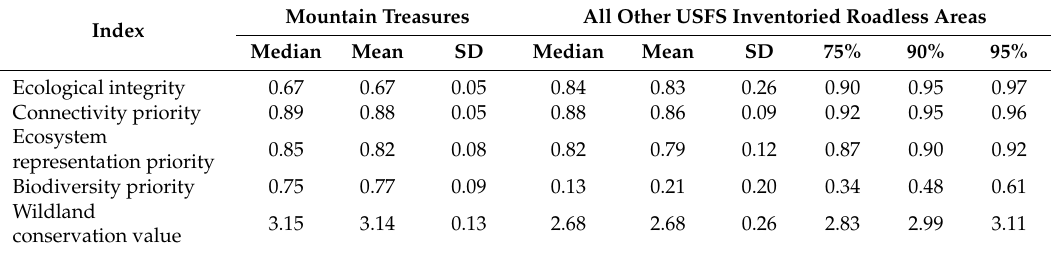
Figure 4. Map of the connectivity priority value between protected areas for the Southern Appalachian Mountains, highlighting the Mountain Treasures based on data from Belote et al. (2016). Many of the Mountain Treasures lie between existing protected areas and therefore represent important priorities for maintaining connections between existing conservation reserves including the Great Smoky Mountains National Park and wilderness areas on the Nantahala and Pisgah National Forests.